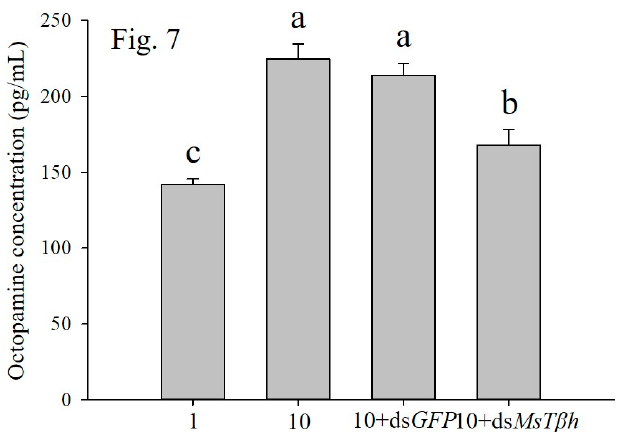
Figure 7. Effects of high density (10 larvae per jar) and 10 + ds MST β H silencing on octopamine level of larvae. ds GFP has been as control. Data are presented as the mean ± SE, n = 3. Different characters denote significant difference at p < 0.05.